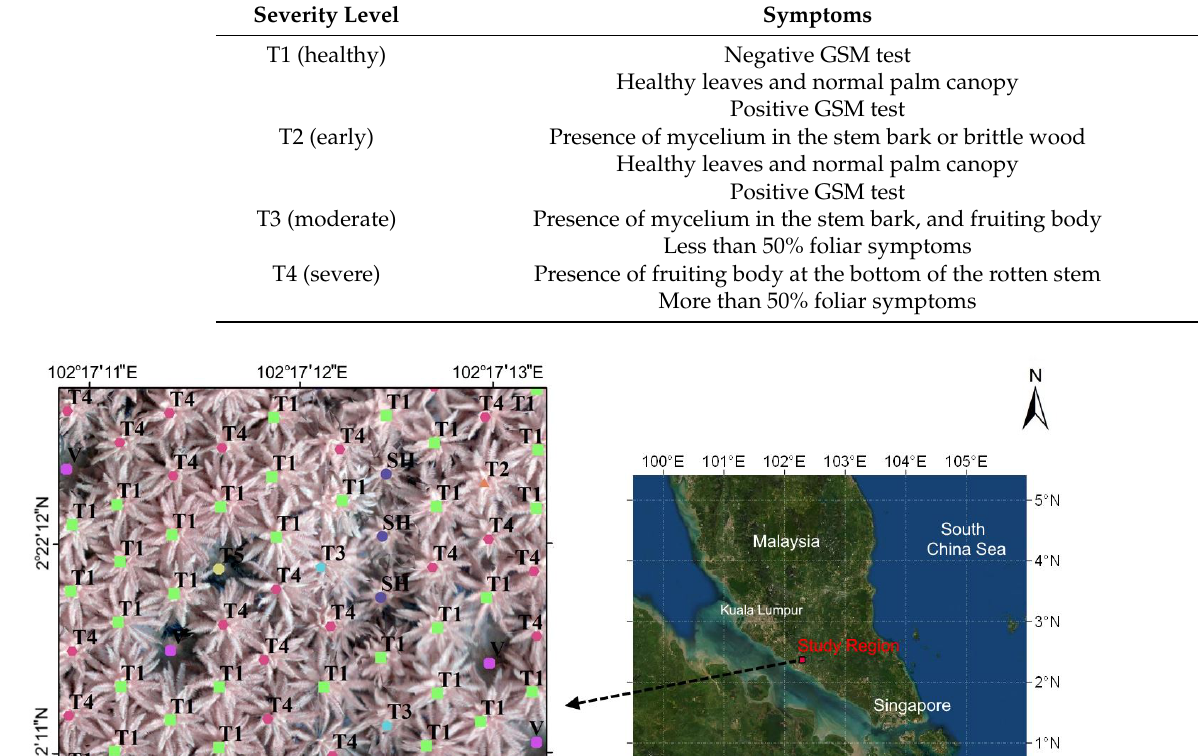
Table 1. Classification of Ganoderma severity levels based on visual symptoms and GSM test.